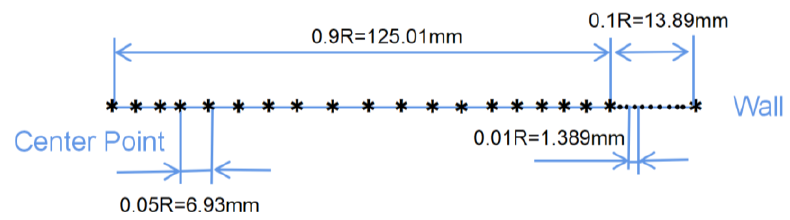
Figure 1. LDV test location of the model test.